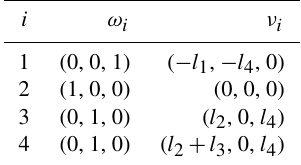
Table 4. The ROM of the upper limb joints in the ISB system.